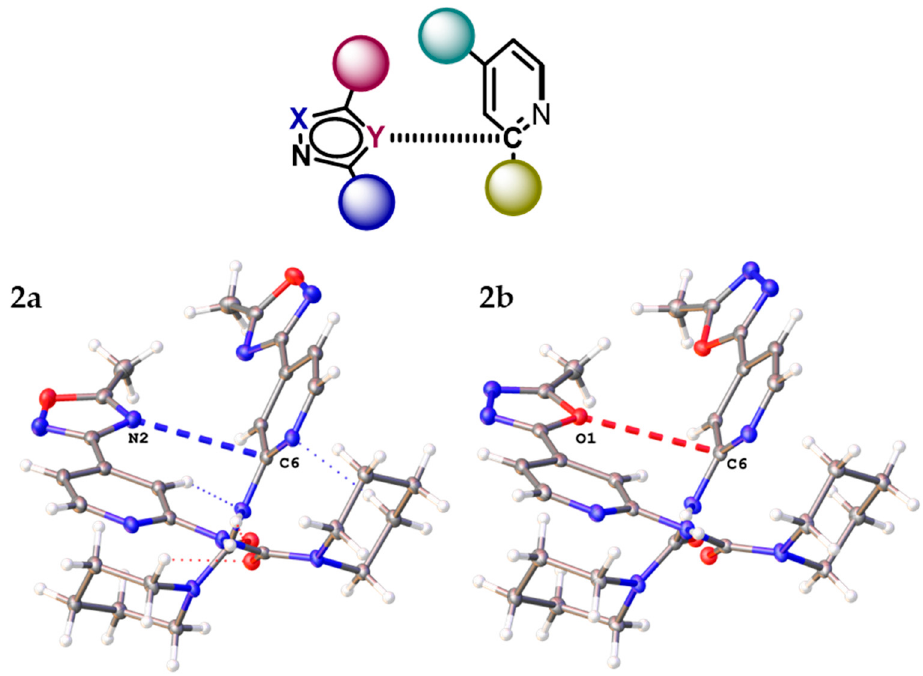
Figure 6. lp– π (oxadiazole)···(pyridine) interaction in the XRD structures of 2a , b .